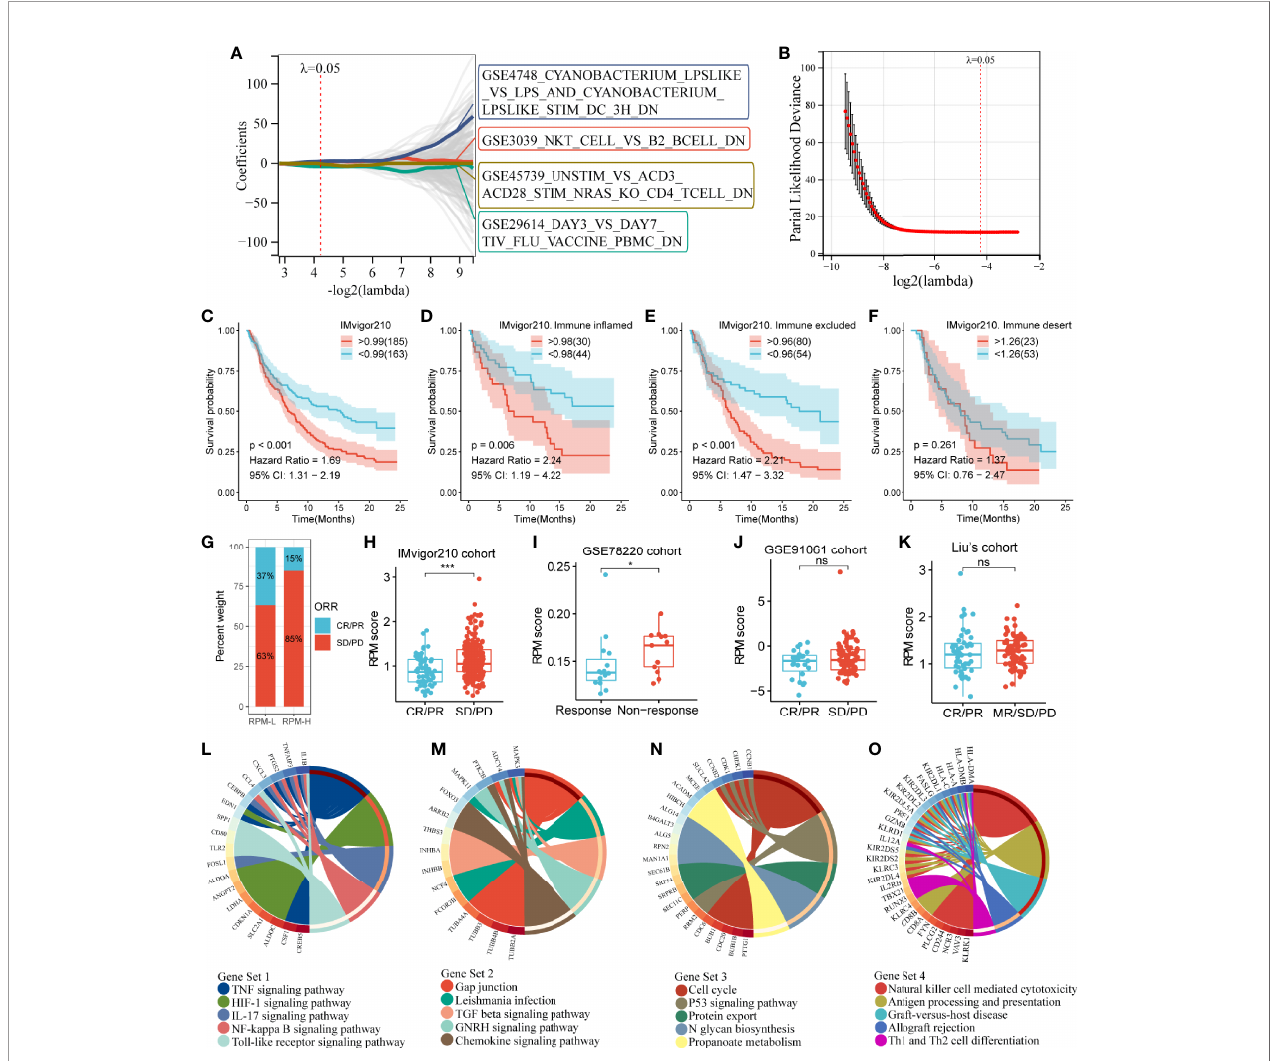
FIGURE 3 | Construction of an IGS-based risk prediction model (RPM). (A, B) LASSO regression analysis identi fi ed four gene sets to construct an RPM. (C) Kaplan – Meier survival analysis showed that RPM-L had a better prognosis than RPM-H. (D – F) Subgroup analysis based on immune phenotypes revealed the difference in survival between RPM-H and RPM-L groups in immune-in fl amed ( D ), -excluded (E) and -desert (F) subtypes. (G) The response rate to PD-L1 immunotherapy was signi fi cantly higher in the RPM-L than that in the RPM-H. (H) Patients with CR/PR had a lower RPM score than those with SD/PD. (I – K) The predictive ability of RPM for immunotherapy response was validated in GSE78220, GSE91061, and Liu ’ s cohort. (L – O) KEGG pathway analysis of the genes in Gene Sets 1 – 4. * P < 0.05, *** P < 0.001; ns, nonsigni fi cant; RPM, risk prediction model; LASSO, least absolute shrinkage and selection operator; PD-L1, programmed cell death-ligand 1; CR, complete response; PR, partial response; SD, stable disease; PD, progressive disease; KEGG, Kyoto Encyclopedia of Genes and